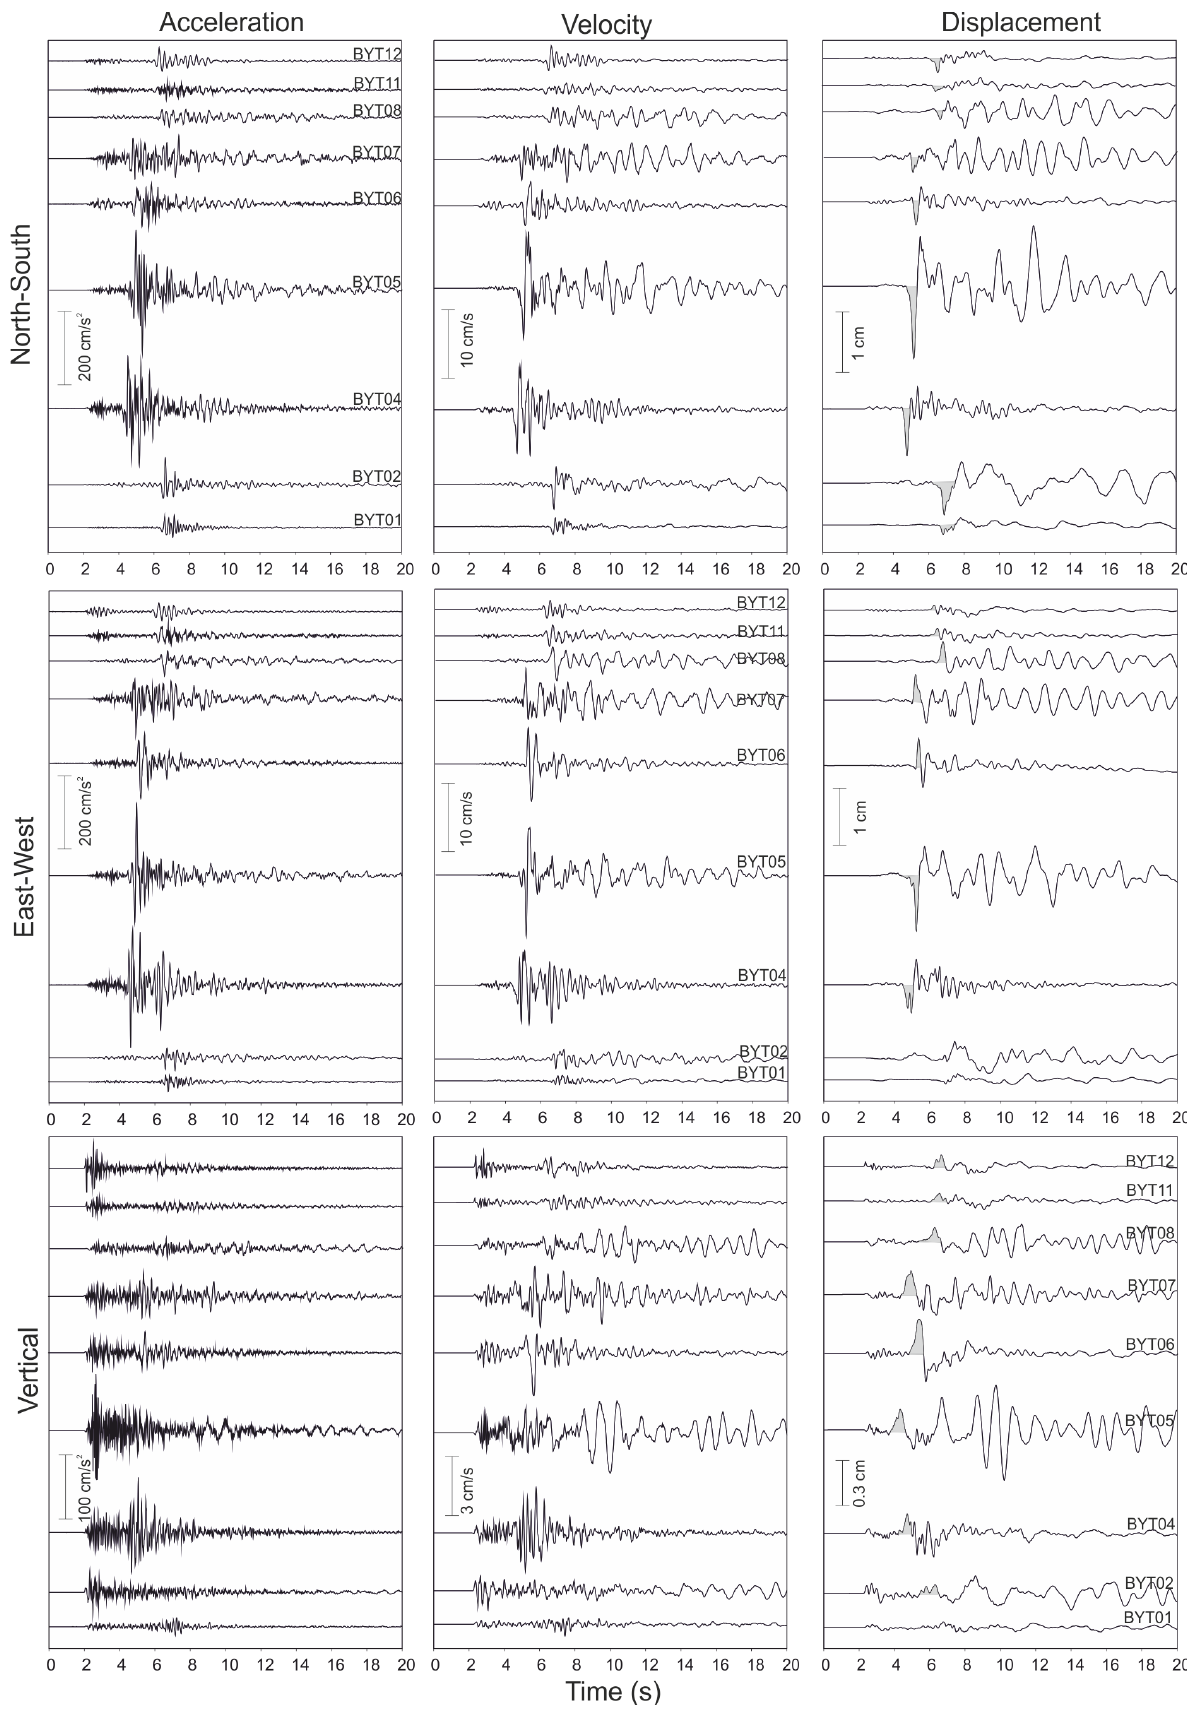
Figure 5. Acceleration (left), velocity (center) and displacement (right) time histories of the Gemlik earthquake recorded at the BYTNet sta- tions. All records start 2 sec before the P arrivals. Different amplitude scale is used for the vertical components and the horizontal compo- nents to easily notice the S wave polarizations and the surface wave